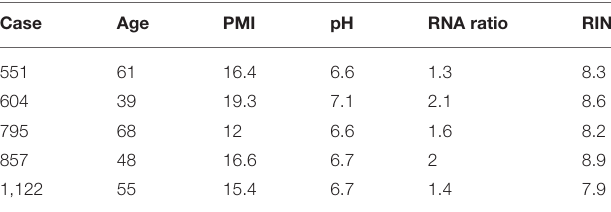
TABLE 1 | Demographics of postmortem human subjects used for CRH + cell